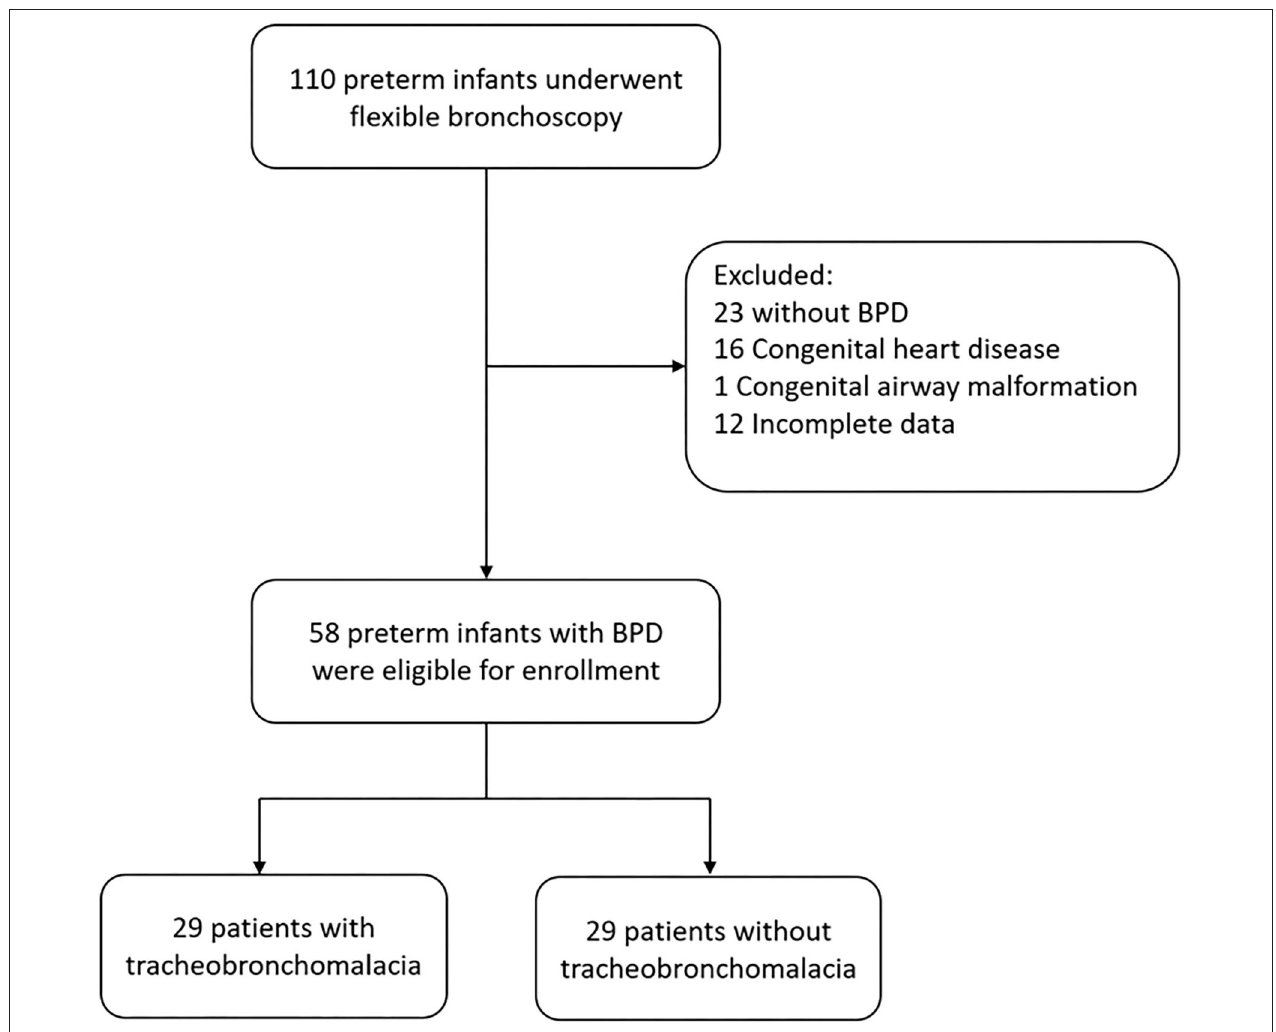
FIGURE 1 | Flow diagram of study inclusion of preterm infants with BPD who underwent flexible